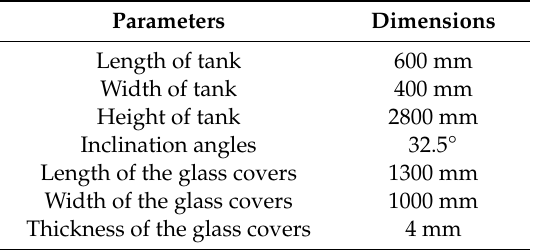
Table 3. Design parameters for the studied solar